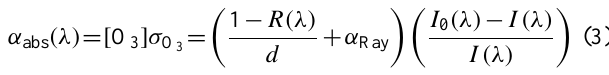
Fig. 2. (a) Example spectra of the transmitted intensity of He and N 2 through the 365, 405, and 455nm IBBCEAS cavities. The structure observed for the 365nm channel is due to the etalon structures from the 365 nm LED. (b) The derived reflectivity curves of the 365, 405, and 455nm centered mirrors from Eq. (2).